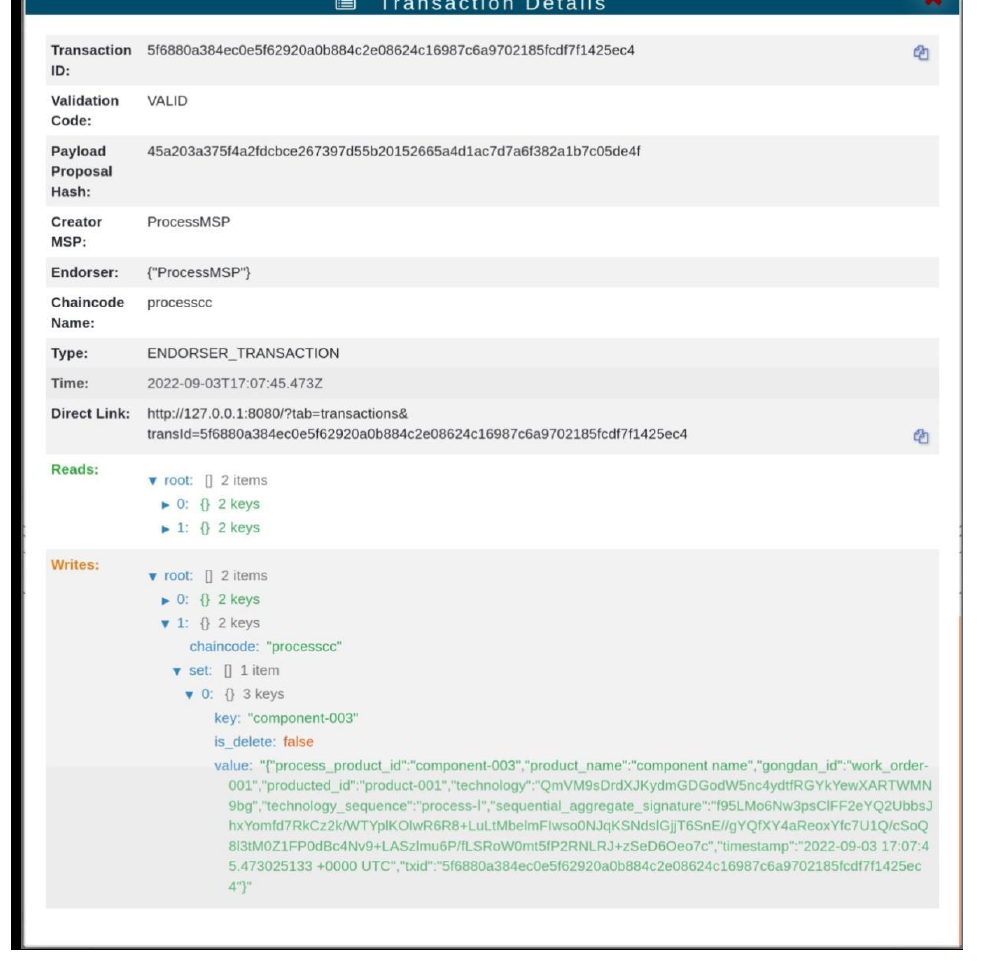
Figure 7. Block information generated by channels in discrete workshops. In addition, the traceability function of product production process data is shown in Figure 8. The production process data can be traced, including purchasing contract in- formation, product information, product drawings, component processing and assembly, and quality inspection information.